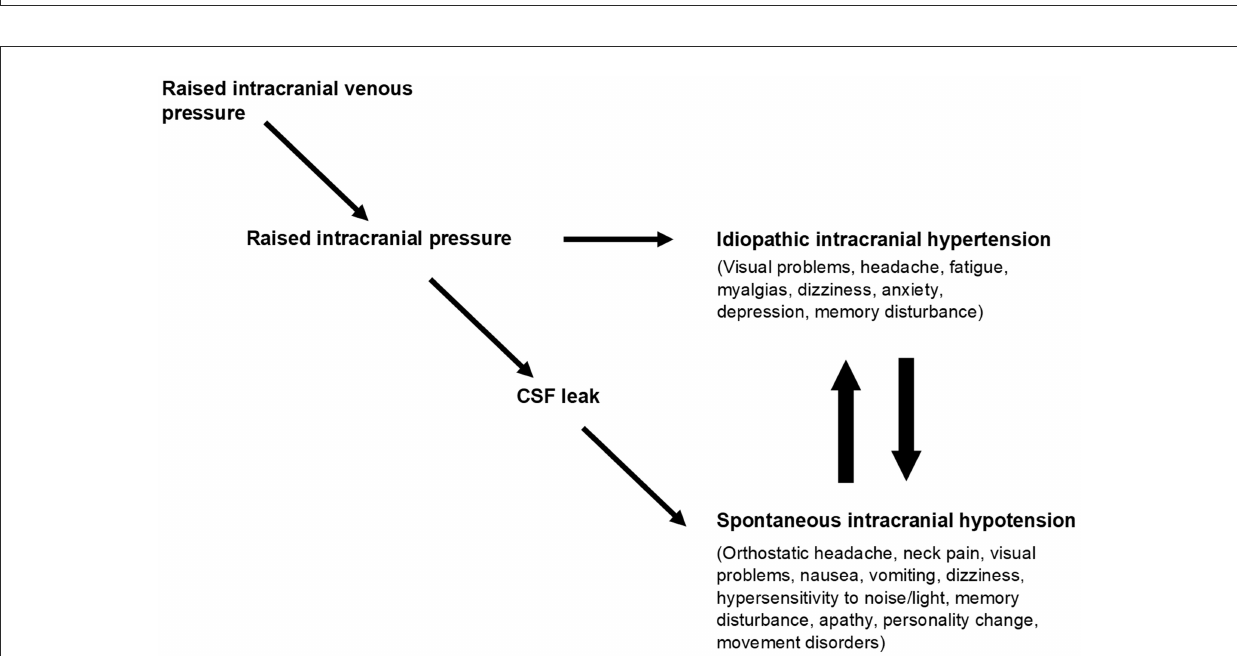
FIGURE4 Obstruction to cranial venous outflow causes a rise in intracranial venous pressures leading to a rise in intracranial pressure and the syndrome of IIH. If a CSF leak develops before IIH becomes evident, then the physiological disturbance manifests as spontaneous intracranial hypotension (SIH). IIH and SIH have multiple overlapping symptoms, and patients may reach an equilibrium position between them or may cycle between one and the other, reflecting opposing forces on intracranial pressure. Taken from “A paradigm for chronic fatigue syndrome: caught between idiopathic intracranial hypertension and spontaneous intracranial hypotension; caused by cranial venous outflow obstruction” by J Nicholas P. Higgins & John D. Pickard. Fatigue: Biomedicine, Health & Behavior 2021, 9:3, copyright © 2021 ACFS/ME reprinted by permission of Informa UK Limited, trading as Taylor & Francis Group https://www.tandfonline.com on behalf of